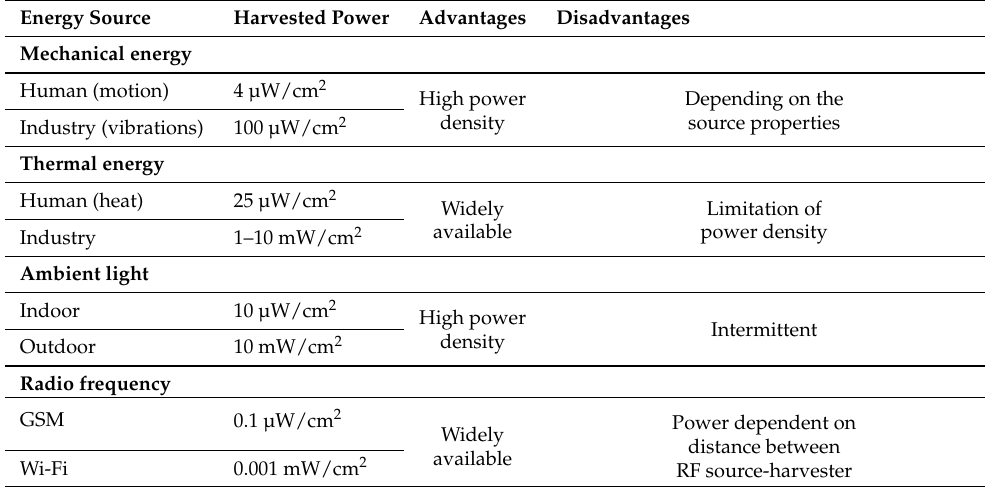
Table 4. Available power from different energy sources (literature